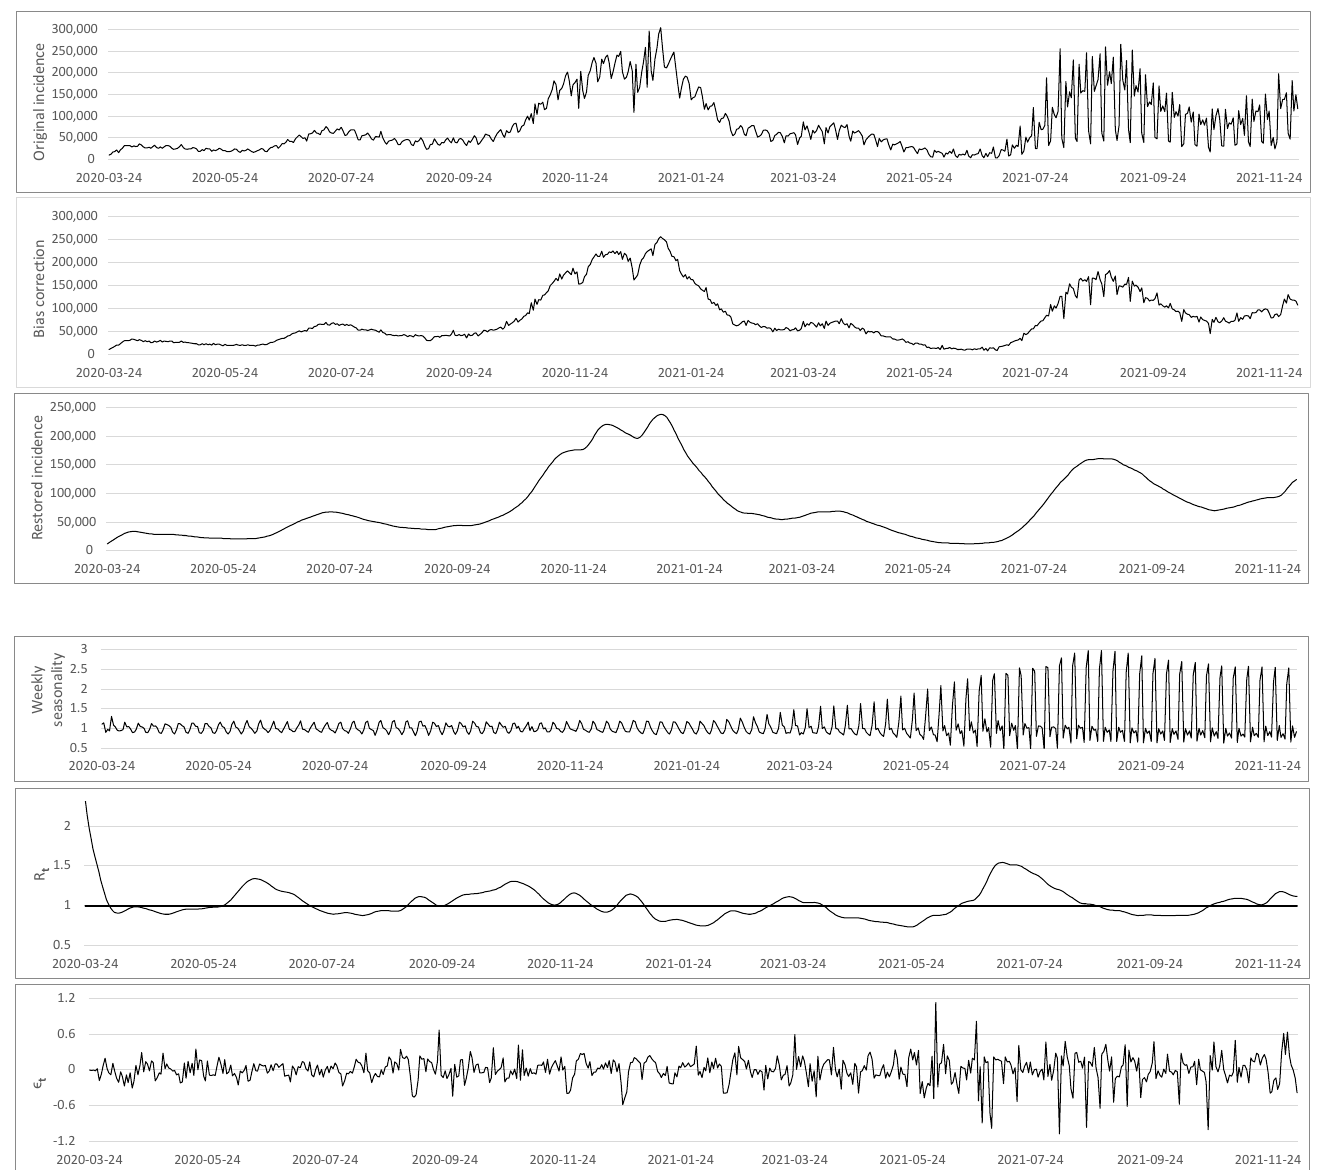
Figure A2. From top to bottom: (i) the original incidence curve i 0 after bias correction ˆ i t , (iii) the restored incidence curve using the renewal equation i r bias correction factors q t , (v) the reproduction number estimation R t and (vi) the normalized error − ˆ i t ) / ( i r ) a , where a is the optimal exponent obtained by regression (see Table ε t = ( i r t t